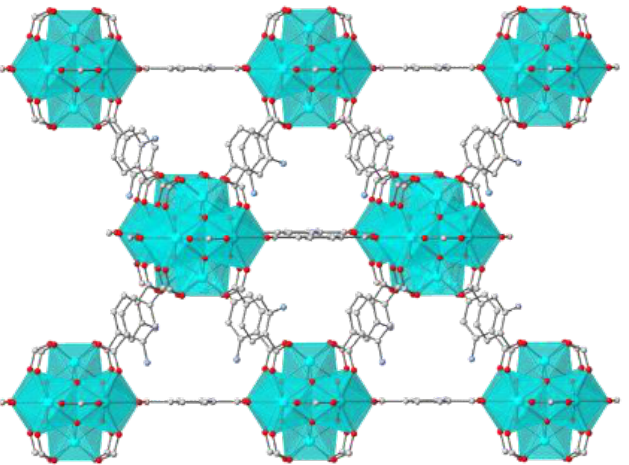
Figure 1. Representation of the structure of MOR-1. Color code: C, grey; O, red; N, blue; Zr, cyan.